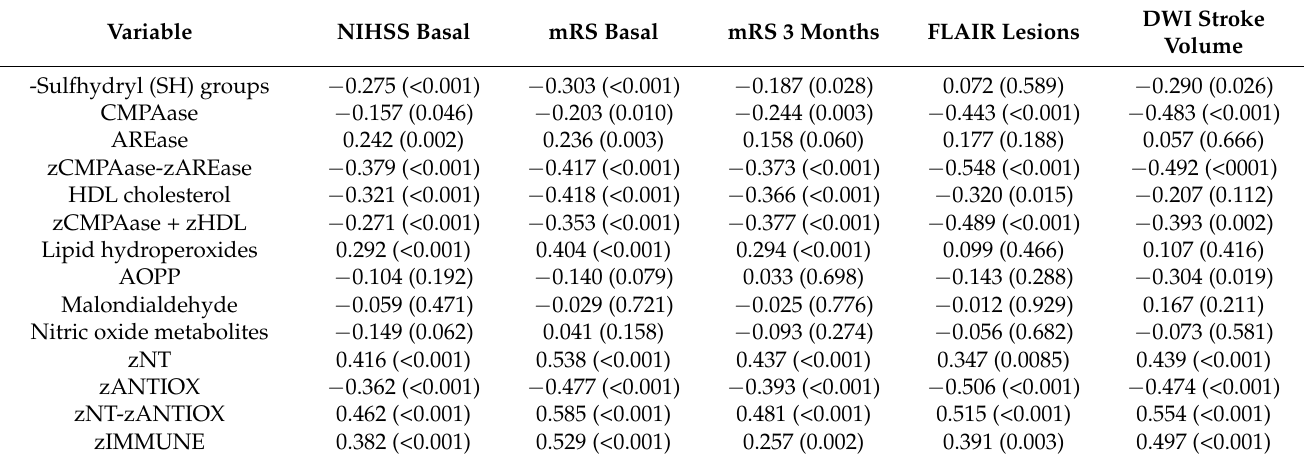
Table 4. Intercorrelation matrix.